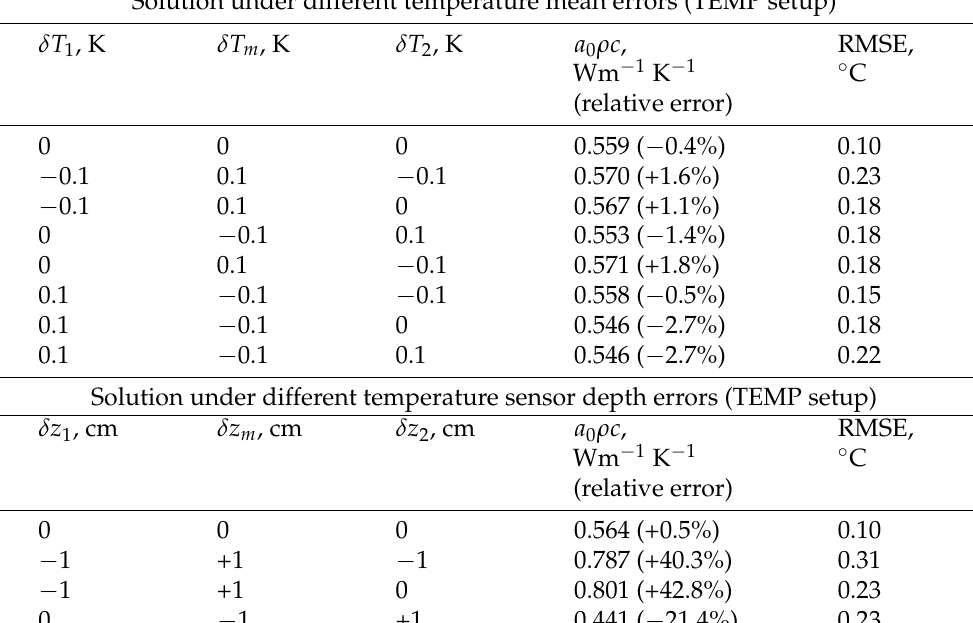
Table 1. Inverse problem solution as a function of input data errors. δ ( · ) is a mean error of variable ( · ). True solution is a ρ c = a w ρ c = 0.561 Wm − 1 K − 1 . The solutions with zero input data errors and with maximal | a 0 − a w | are